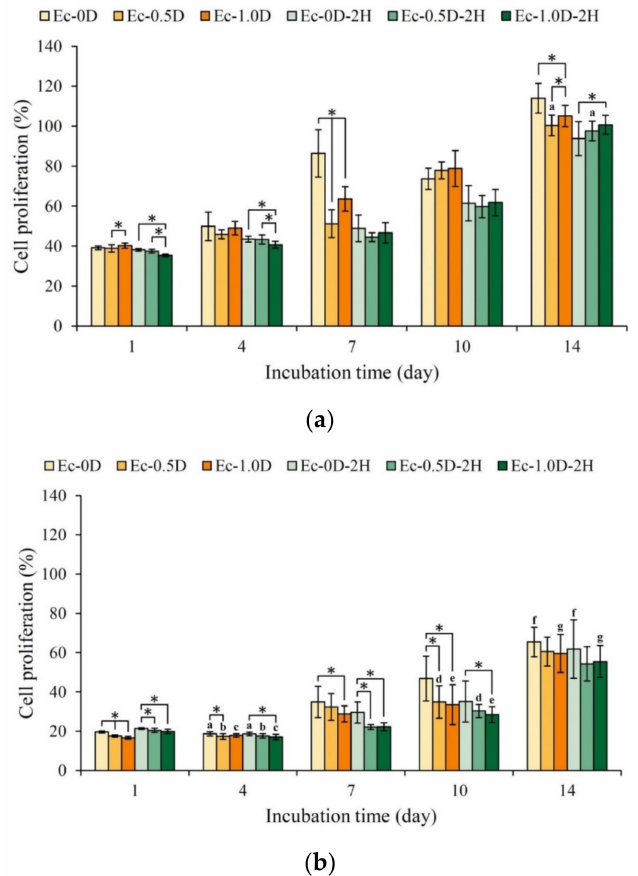
Figure 9. Proliferation of the hydrogel regenerated membrane in contact with NIH-3T3 ( a ) and L929 ( b ) cells for 1, 4, 7, 10, and 14 days (the symbol * indicates that each group shows p < 0.05, and the same alphabet indicates that the experimental group after t -test shows p >